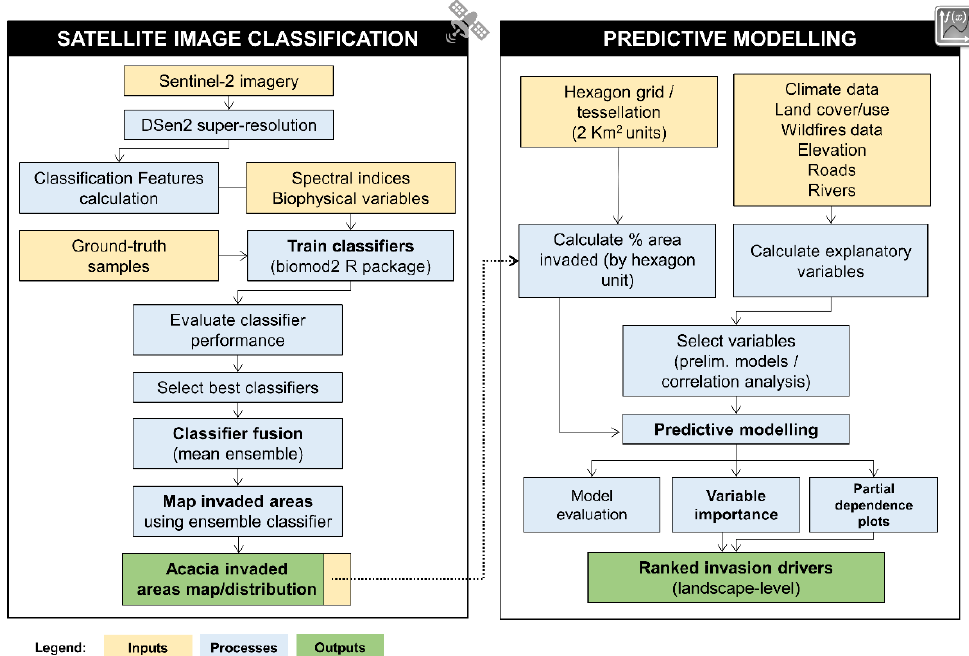
Figure 1. General workflow proposed for addressing A. longifolia mapping and landscape-level drivers combining satellite image classification ( left-side ) and predictive modeling ( right-side ).